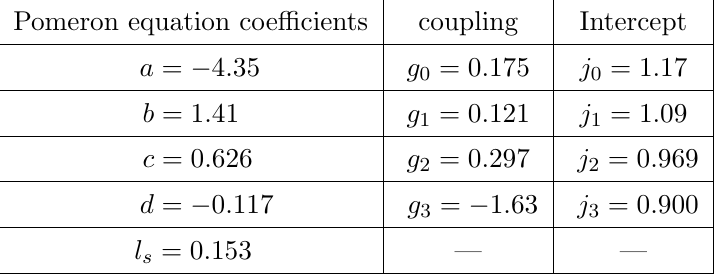
Table 1 . The nine parameters for our best (cid:12)t. As an output we also show the intercept of the (cid:12)rst four pomeron trajectories (in fact we forced the second trajectory to have the soft pomeron value, so only the other values are a prediction of the